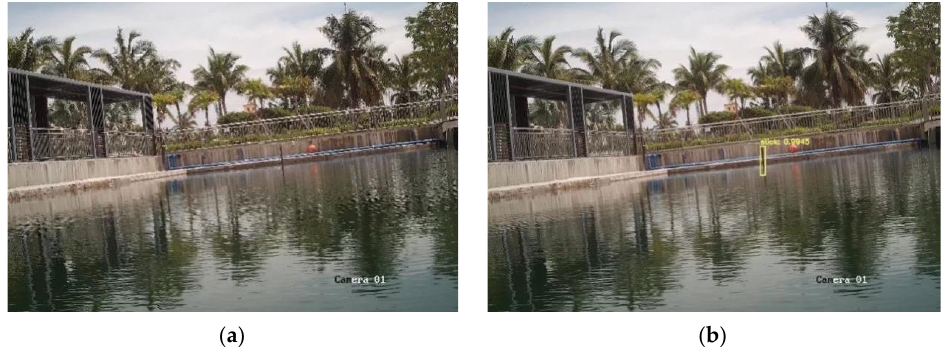
Figure 7. Small target detecting results. ( a ) Using original YOLOv3, ( b ) using YOLO with the fourth feature map.